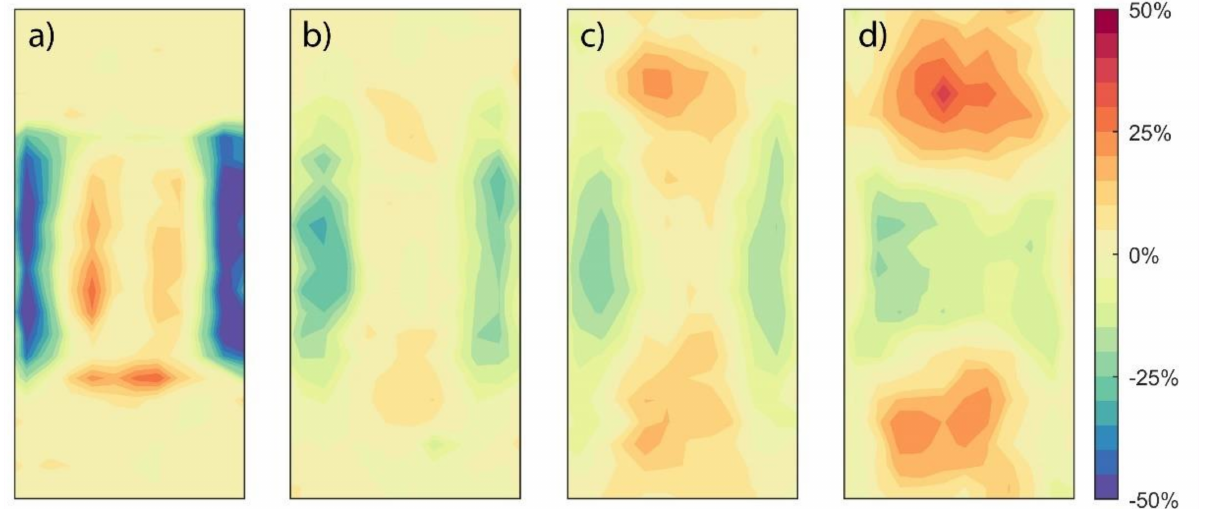
Figure 7. Local differences in the data from Figure 6. Depicted is the axial velocity from MRV minus the axial velocity from CFD divided by the average intrinsic velocity (0.0525 m/s) at the following distance from the inlet of layer four: 0.02 mm ( a ), 1.46 mm ( b ), 2.72 mm ( c ), and 3.56 mm ( d